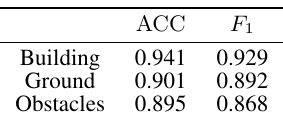
Table 2. Evaluation of classification